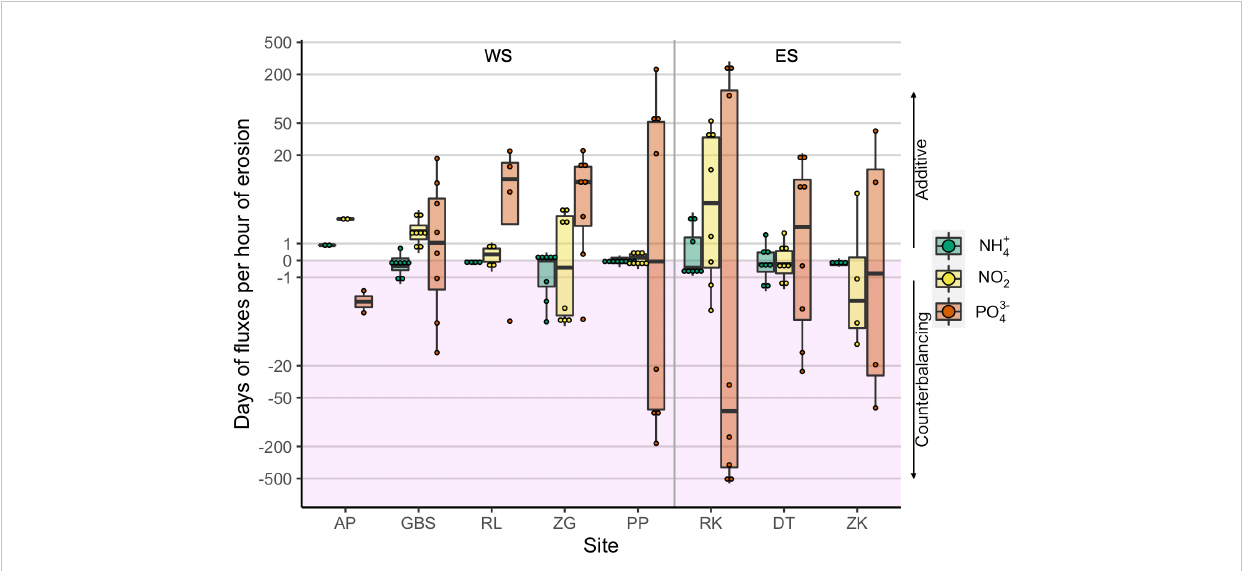
FIGURE 5 Equivalence of one hour of erosion to days of undisturbed fl uxes. All replicates of both the high and the low water line locations are pooled together by nutrient per site. The additive effect of erosion on the undisturbed fl uxes is shown in the white area with positive values, while the cases with a counterbalancing effect are depicted in the shaded area with negative values. Vertical line separates between WS sites arranged from fresh to marine salinities and sites in the ES. Notice the logarithmic scale in the y